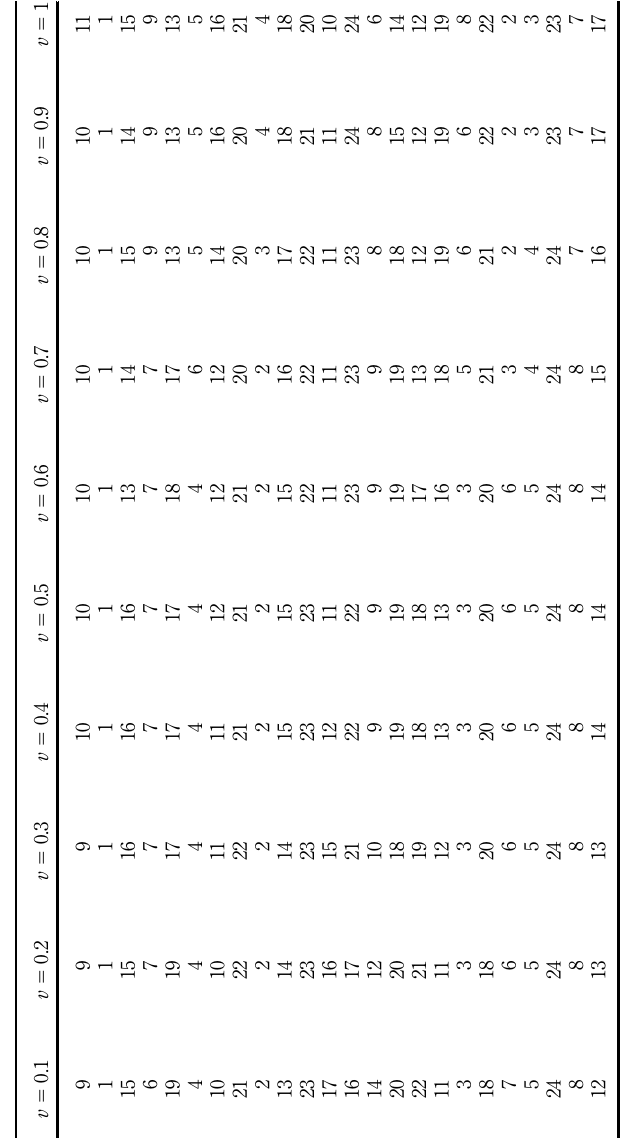
Table 10. The ranking of the alternatives for different “ v ”